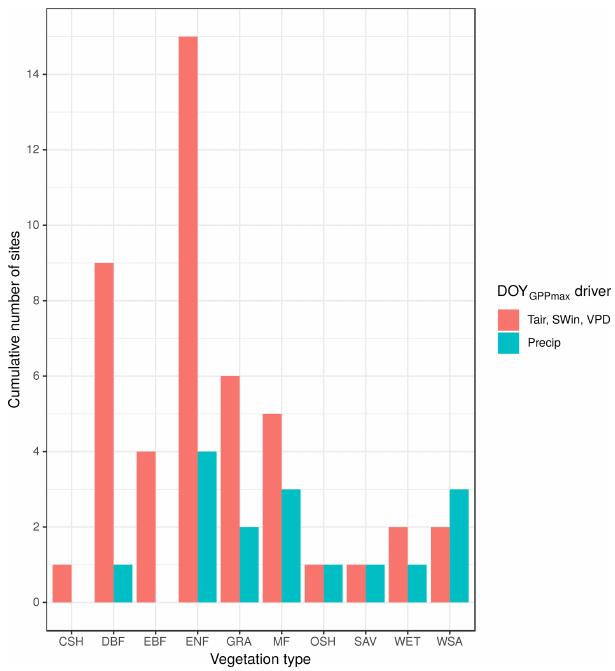
Figure 5. Contribution of each climate variable to explain the inter- annual variation in DOY GPPmax per vegetation type. CSHs: closed shrublands ( n = 1); DBF: deciduous broadleaf forest ( n = 10); EBF: evergreen broadleaf forest ( n = 5); ENF: evergreen needleleaf forest ( n = 15); GRA: grassland ( n = 8); MF: mixed forest ( n = 5); OSHs: open shrublands ( n = 1); SAV: savannas ( n = 1); WET: per- manent wetlands ( n = 2); WSAs: woody savannas ( n = 3). Each bar shows the cumulative number of sites where each climate variable is statistically